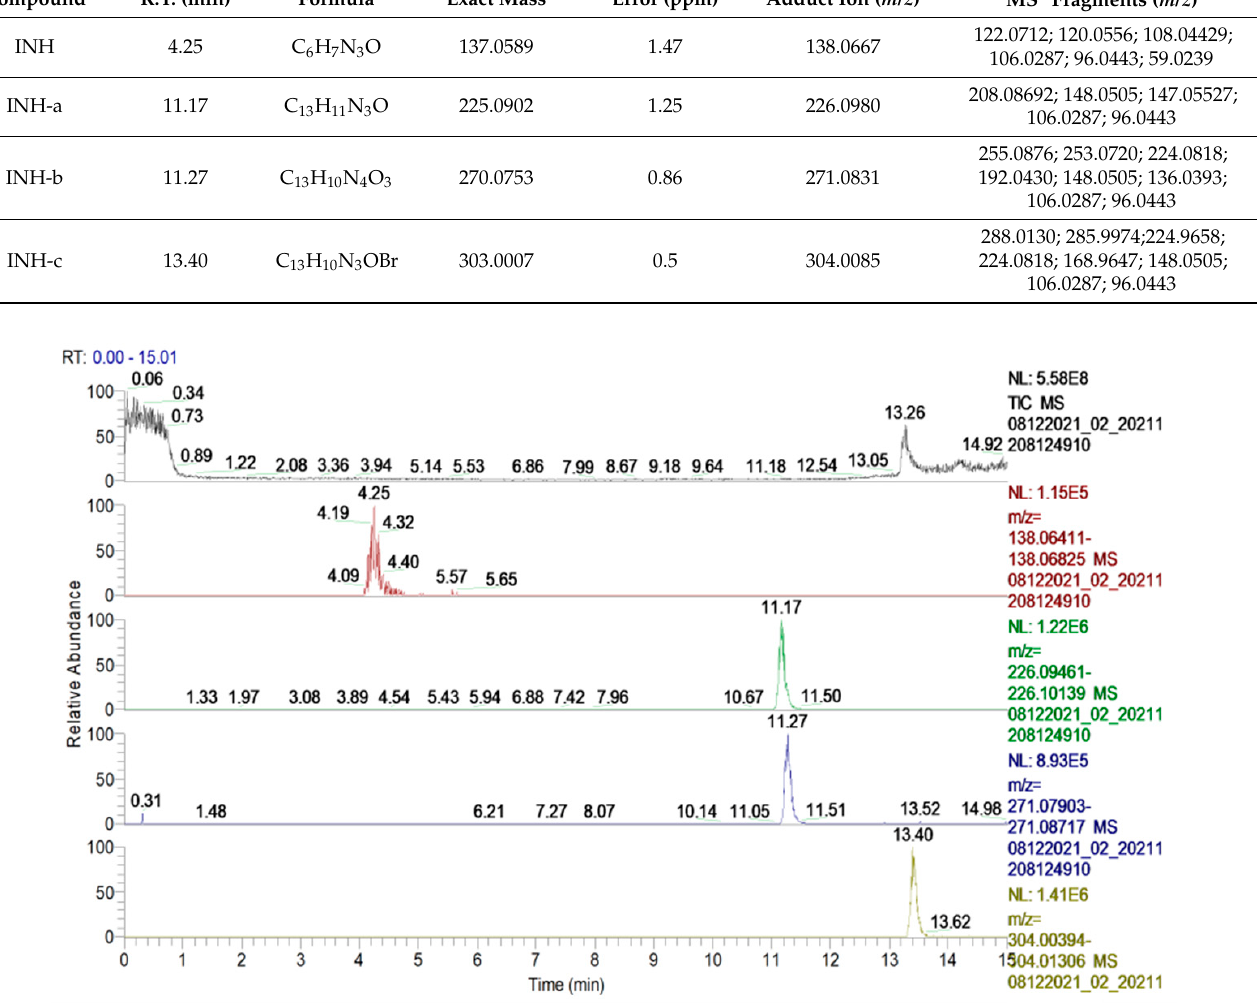
Figure 1. UHPL-HRMS full scan extracted chromatograms of the target compounds (isoniazid and its derivatives). From top to bottom: INH m / z 138.0667; INH-a m / z 226.0980; INH-b m / z 271.0831; INH-c m / z 304.0085 . Table 1. The target compounds, deprotonated precursors and fragment ions. The common frag- ments for the parent compound and its derivatives are in bold .